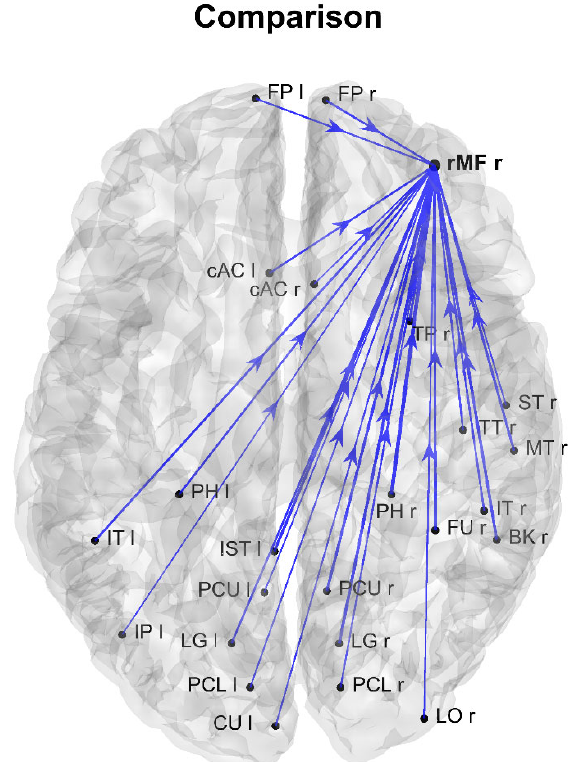
Figure 6. Network showing the differences between the normalized connections in the two groups, with reference to the connections that enter the unique AQ-modulated sink ROI identified in Figure 2 (and confirmed by Figure 4). Only differences with an absolute value higher than 0.025 are shown. Blue lines denote connections higher in the group with higher autistic scores (AQ score ≥ 17). It is evident that the ROI rMF right is characterized by stronger input connections in the group with higher autistic scores relative to the group with lower autistic scores.